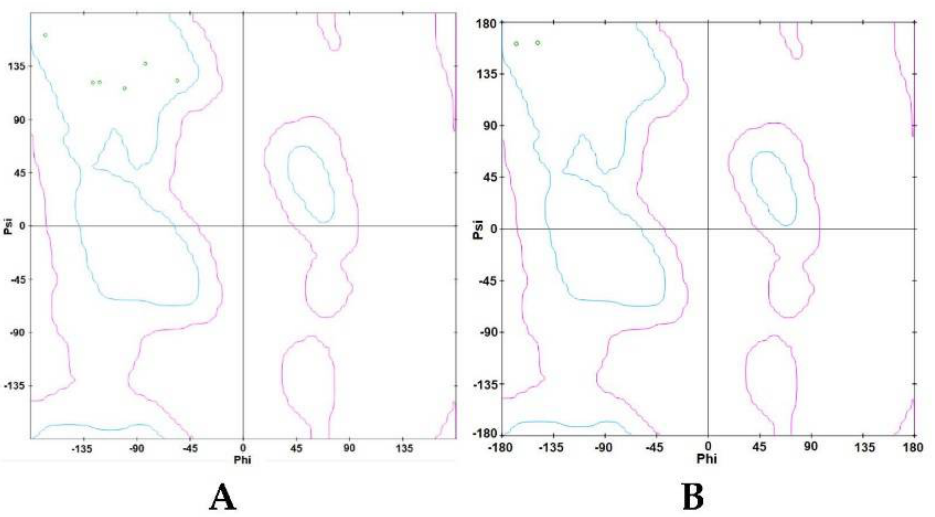
Figure 10. Ramachandran plot of ligands with the highest binding affinity: ( A ) Ramachandran plot of Indeno(1,2,3-cd)pyrene; ( B ) Ramachandran plot of Dibenz(a,h)anthracene. Small green circular portions of the Ramachandran plot represent the amino acid residues.